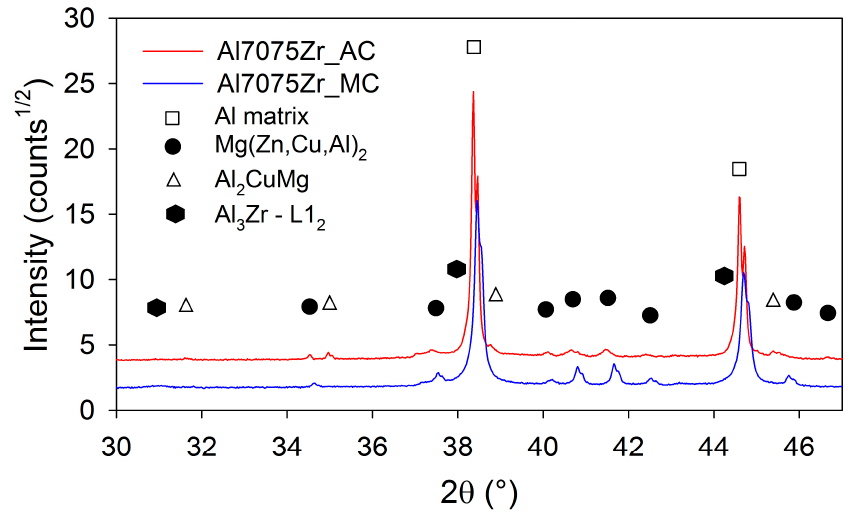
Figure 11. XRD patterns of compacts from atomized and milled 7075Zr.